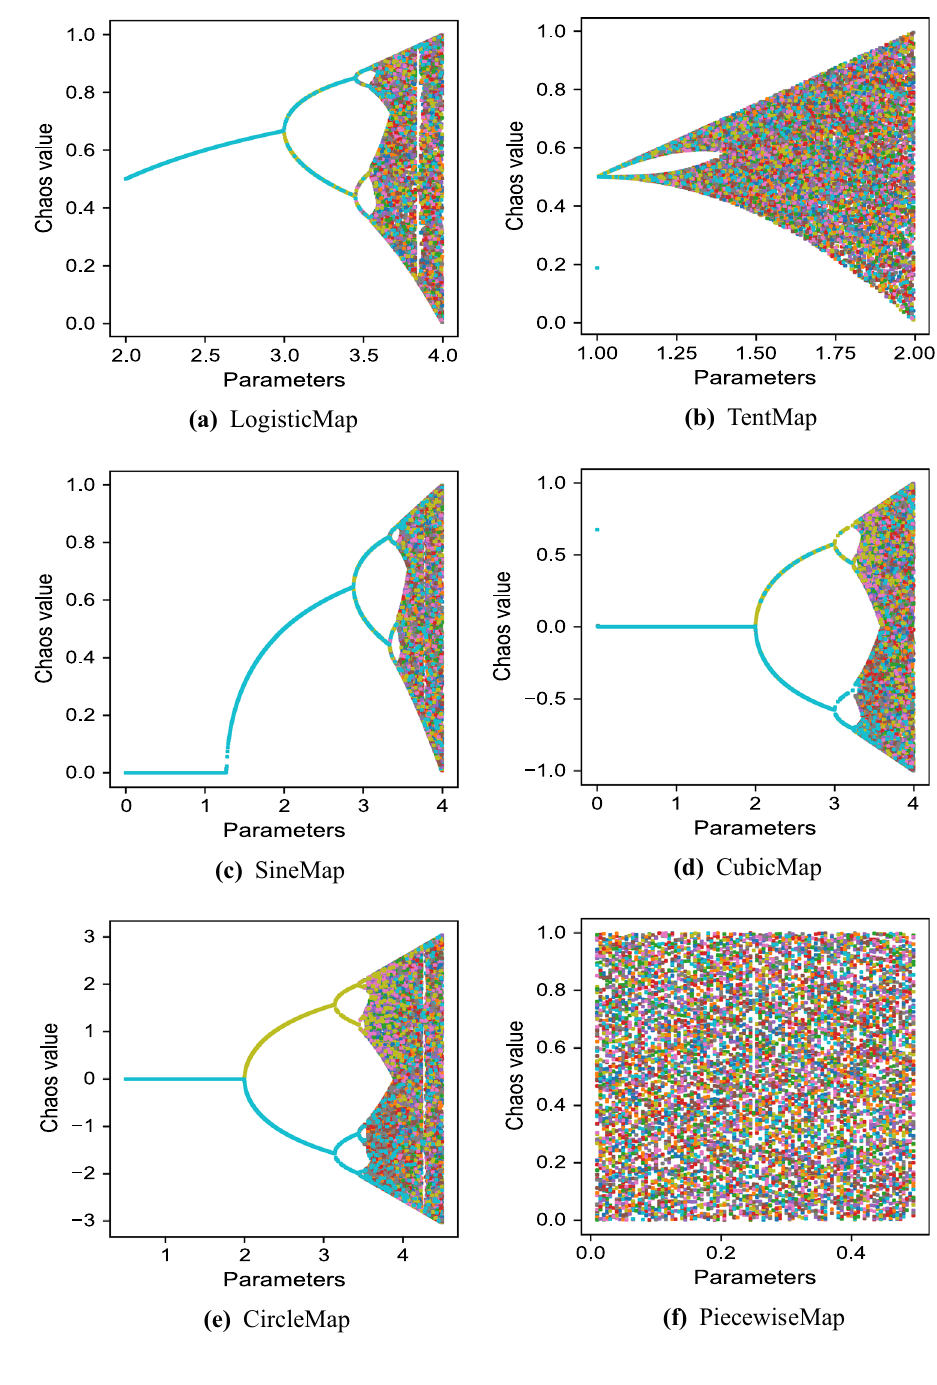
Fig. 4 Bifurcation graphs of six classical